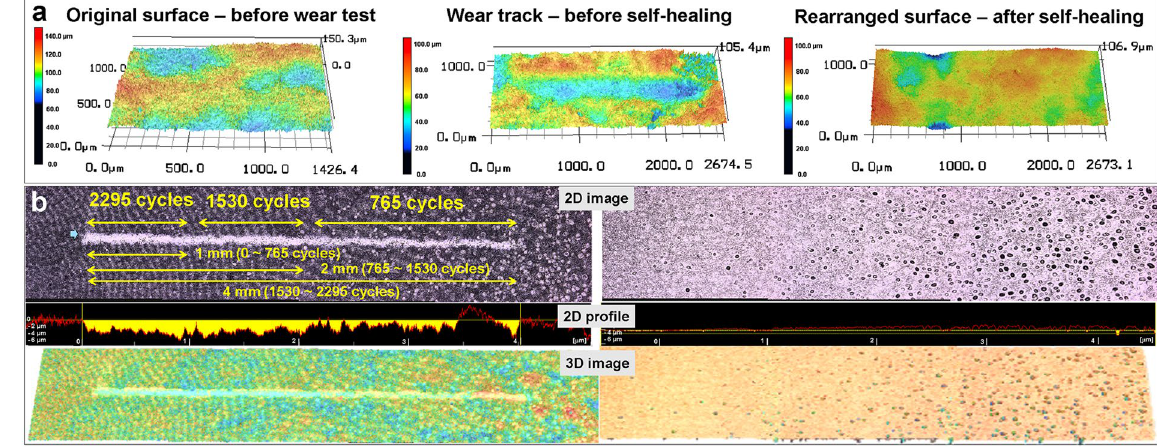
Figure 4. Confocal microscope 2D/3D images of hydrogel coating before/after self-healing. ( a ) Original surface, showing the formation of the wear track after the sliding test under an applied load of 20 mN over 90 cycles and the reconstituted surface of the hydrogel coating after self-healing. ( b ) Total wear track formed on the surface after the sliding test under an applied load of 30 mN over 2295 cycles with respect to the different sliding stroke lengths (1 mm, 2 mm, and 4 mm) and the reconstituted surface of the hydrogel coating after